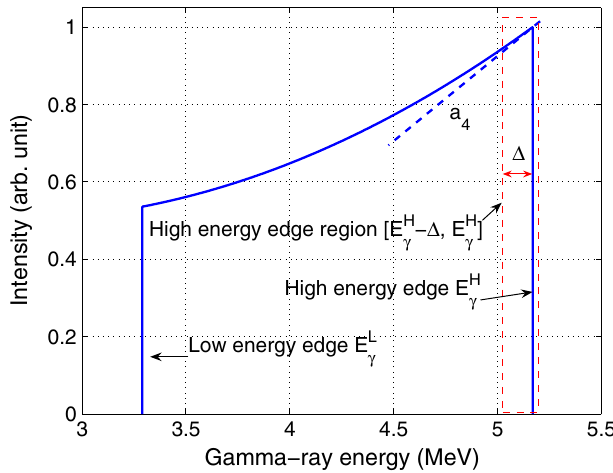
FIG. 2. (Color) The energy spectrum of a Compton gamma-ray beam produced by the head-on collision of a 466 MeV pointlike electron beam with a 789 nm pointlike laser beam. A collimation aperture with radius of 50 mm is placed 60 m downstream from is determined by the the collision point. The low energy edge E L (cid:1) collimation acceptance, while the high energy edge E H is (cid:1) determined by the electron and laser photon energy. The slope of the spectrum at the high energy edge is denoted as a 4